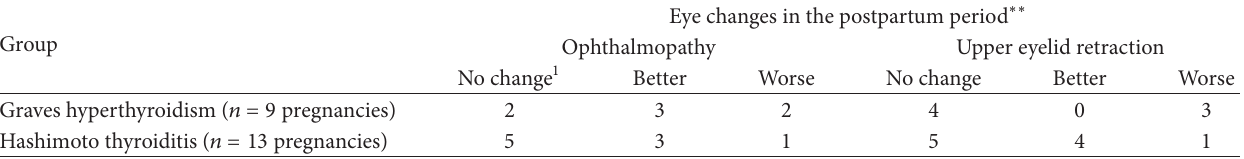
Table 2: Change in eye signs during pregnancy in patients with Graves’ hyperthyroidism and Hashimoto’s thyroiditis. Developed new ophthalmopathy Changes in existing eye signs during pregnancy ∗∗ Group OPHY 1 UER 2 OPHY UER No change Better Worse No change Better Worse Graves’ disease (9 pregnancies) 5 2 1 1 5 2 1 4 Hashimoto thyroiditis (13 pregnancies) 4 1 7 0 6 6 2